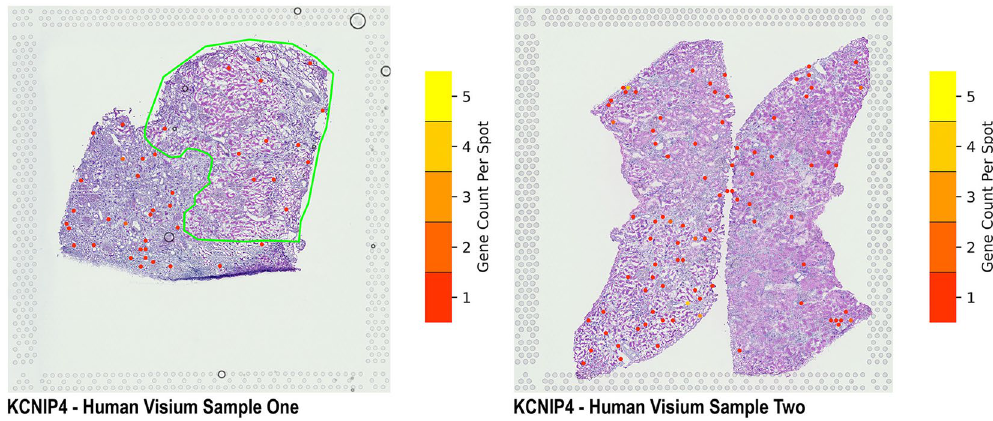
Figure 4. Spatial gene expression of KCNIP4 in human cortical kidney tissue sections. We localized KCNIP4 gene expression within the tubules of both sample one, composed of non-scarred (green) and scarred cortical regions and sample two, composed of non-scarred cortical